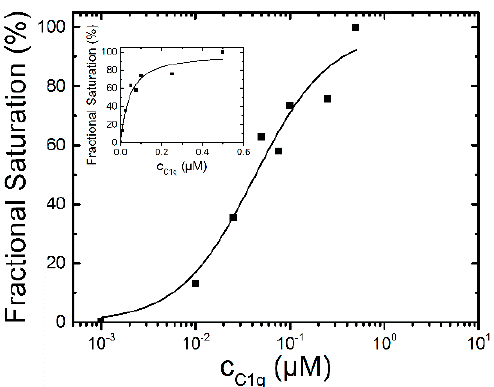
Figure 5. C1q- binding curve to 0.1 µM dPGS-ICC in DPBS at 20 °C. The half maximum binding concentration was determined to be 42 ± 12 nM and n = 1.1.